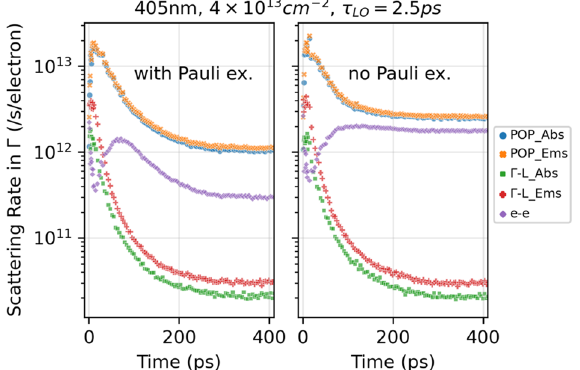
Figure 5. Scattering rates in the Ŵ valley with (left panel) and without (right panel) Pauli exclusion. Both cases D 13 cm − 2 have n 2 ss , Ŵ = 4.2 × 10